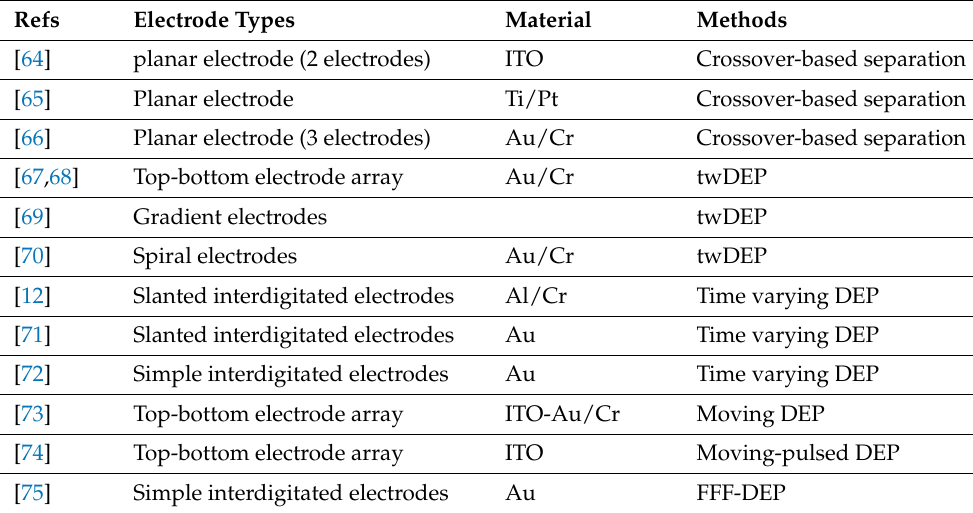
Table 1. Electrode structures used in studied signal-based